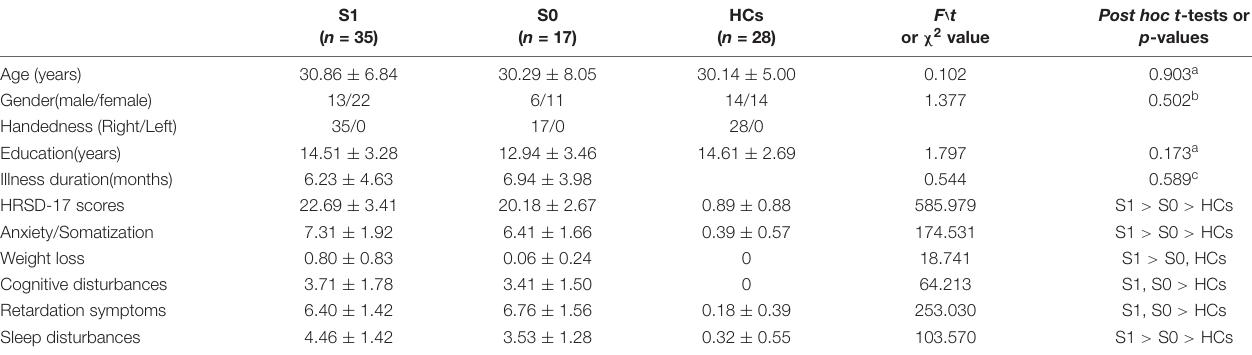
TABLE 1 | Demographic and clinical characteristics of the